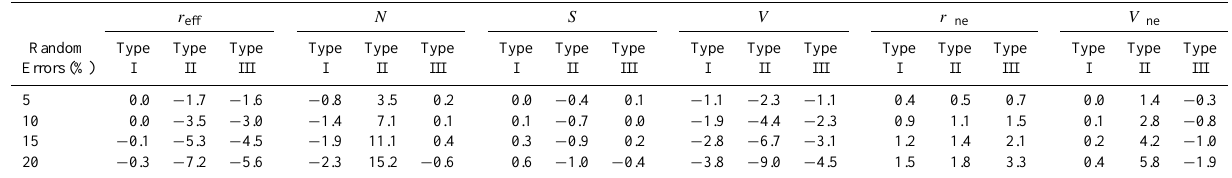
Table 3. Mean of the differences (in percentages) in the retrieved microphysical parameters due to varying amounts of random error in the optical